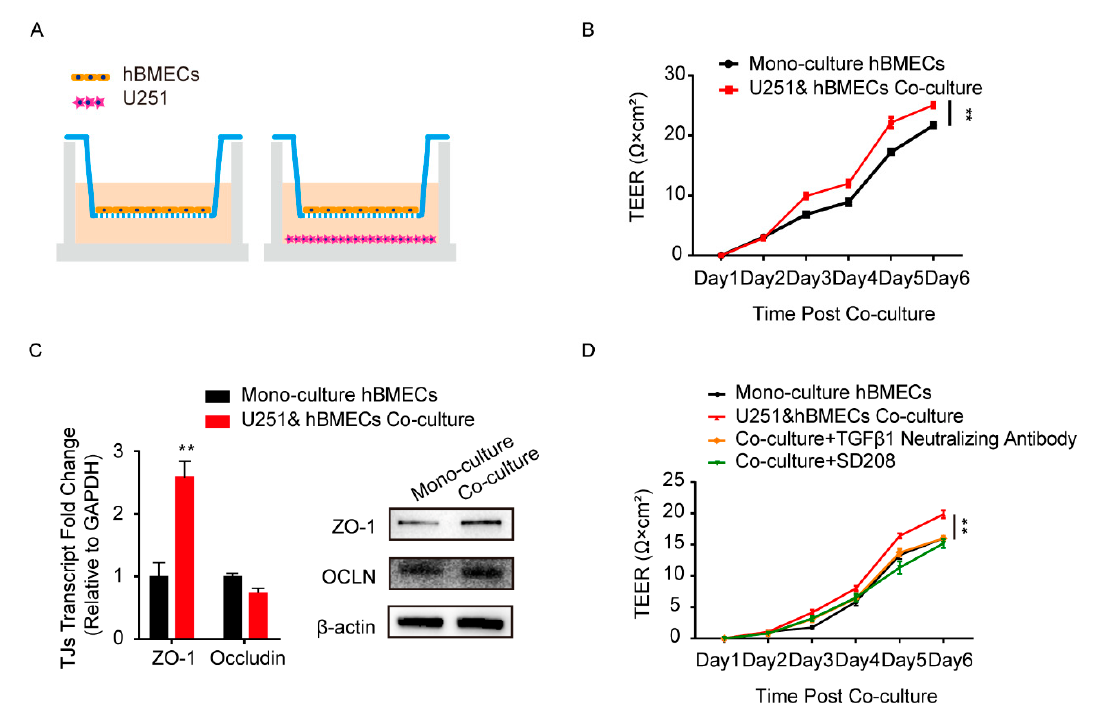
Figure 1. Astrocyte-derived TGF β 1 enhanced brain microvascular endothelial cells (BMECs) barrier function. ( A ) The human brain microvascular endothelial cells (hBMECs) mono-culture and co-culture model with U251. ( B ) Comparison of trans-endothelial electrical resistance (TEER) values of the hBMECs under both culture conditions. ** p < 0.01. ( C ) The expression of TJ proteins ZO-1 and occludin in hBMECs under both culture conditions via qPCR and Western blot. ** p < 0.01. ( D ) Effects of TGF β 1 blocking (with TGF β 1 neutralizing antibody at 10 μ g/mL and with inhibitor SD208 at 10 μ M) on the TEER values of hBMECs with co-culture. ** p < 0.01.